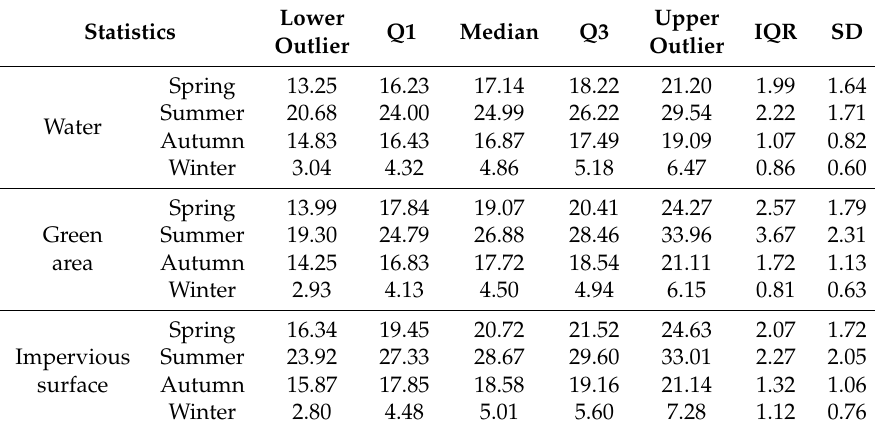
Table A3. Statistics of box plot in